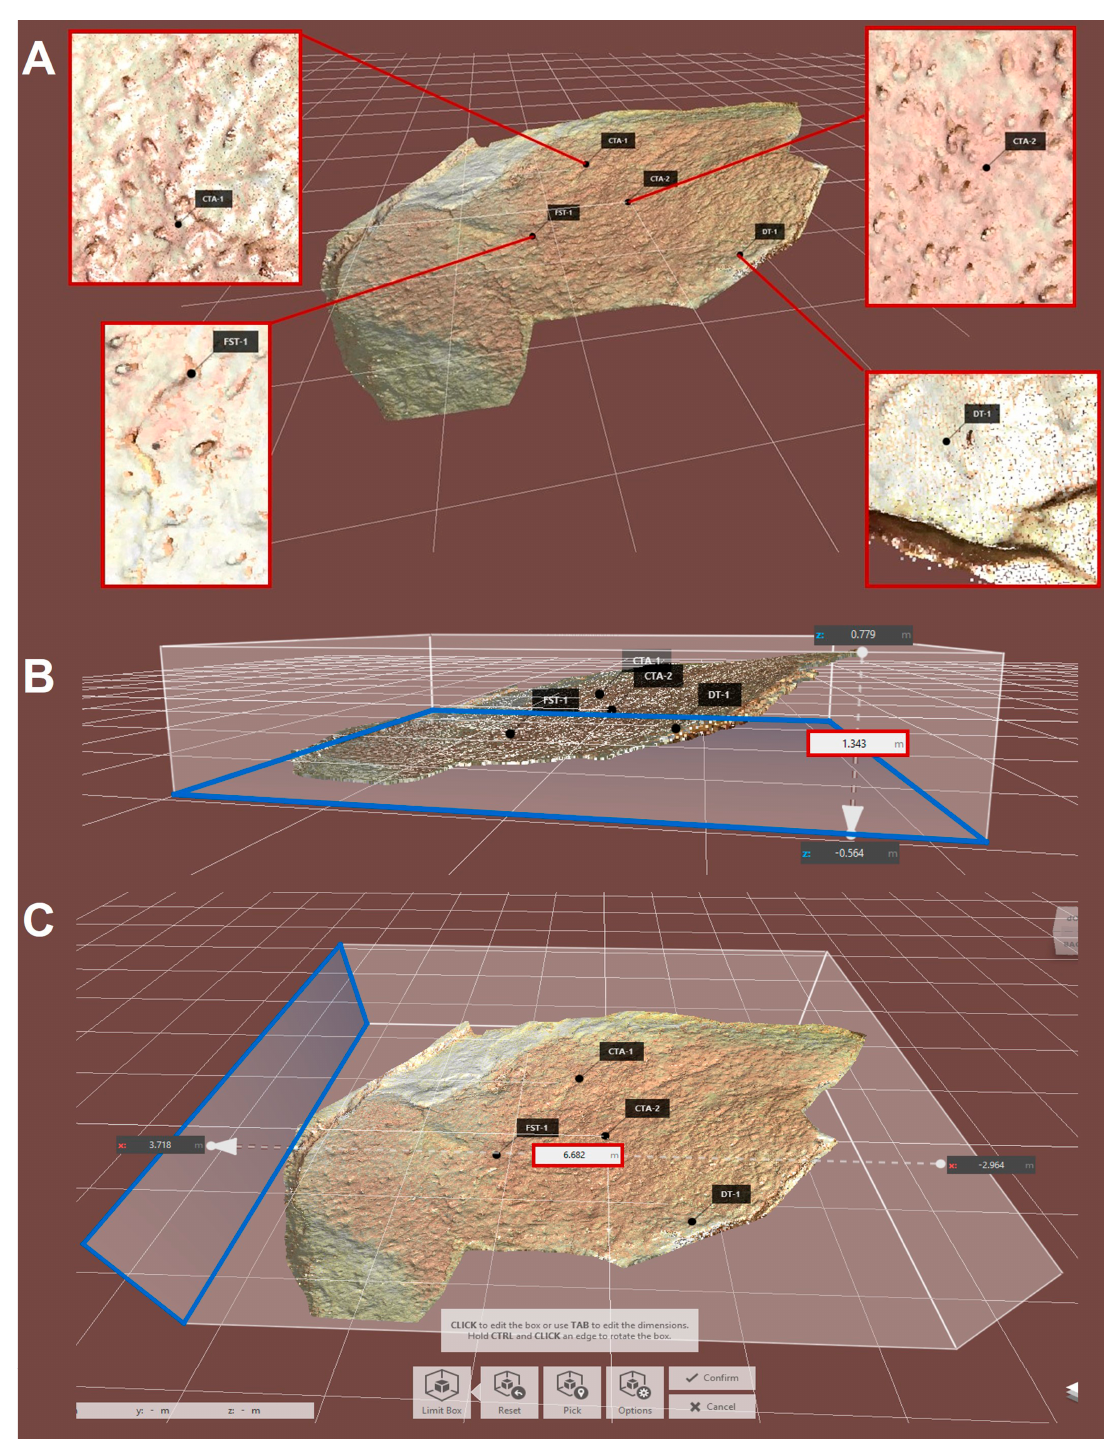
Figure 4. Three-dimensional model of the Upper Cretaceous track surface of Tamajón scanned with a phase-shift scanner. ( A ) Track surface and augmented view of the main crocodyliform tracks (top right and top left), small theropod print (bottom right), and fish fin trace Undichna unisulca (bottom left). ( B ) Lateral view of the tracksite. Total height (1.343 m) of the exposed channel surface. ( C ) Total length (6.662 m) of the exposed channel surface. Modified from [19].